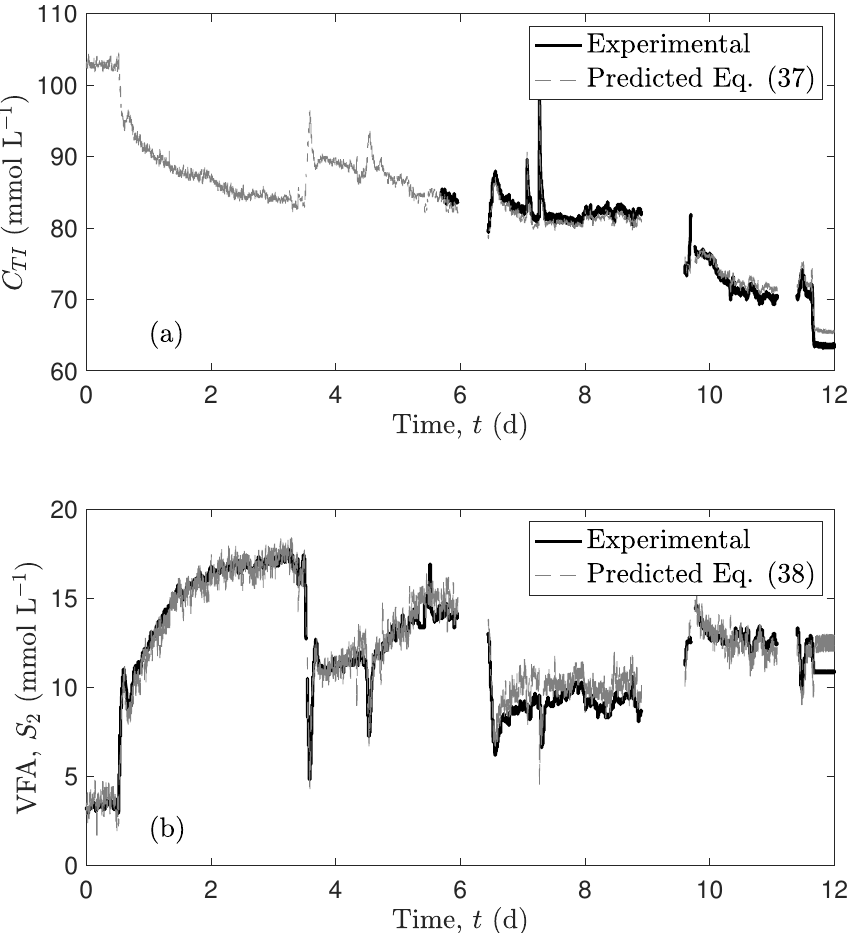
Figure 6. Predictions of the experimental data: ( a ) TIC and ( b )